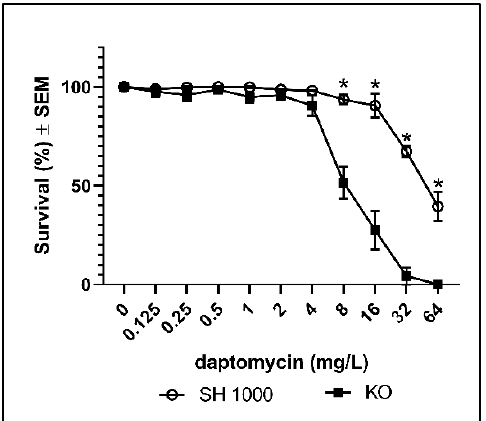
Figure 2. Percentages surviving cells demonstrating the protective effect of catalase against daptomycin treatment of S. aureus biofilms. Biofilms of the wild type (SH1000) and of the catalase deficient strain (KO) were grown for 3 days before overnight treatment with daptomycin. Mean ± SEM of triplicate experimental set-ups are shown. Statistical significance was determined using two-way ANOVA, followed by Bonferroni’s multiple comparison tests. * p < 0.05.